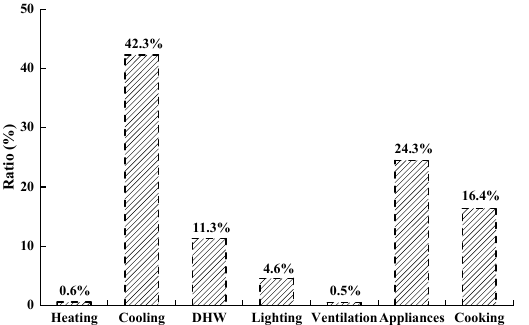
Figure 4. Ratio of different residential end-use energy consumption in a year.